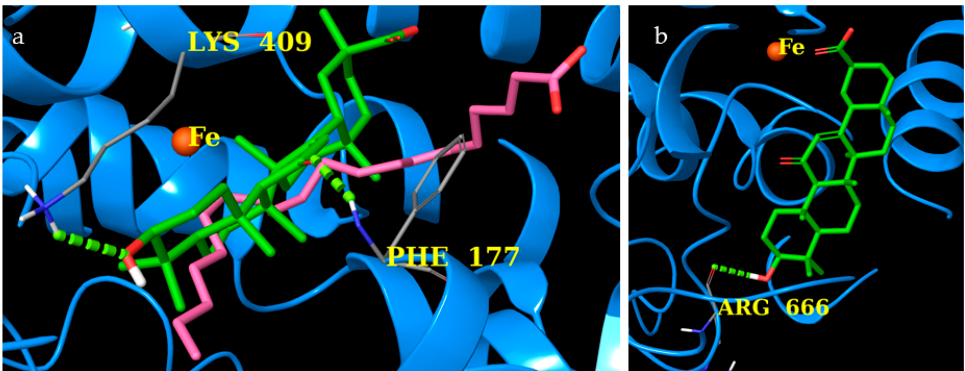
Figure 12. ( a ) Rigid docking and induced fit ( b ) of AG (colored by atom types: C green, O red, polar H white) in the binding site of 5-lipoxygenase (5-LO) (blue ribbons and Fe2+ as an orange sphere). Green dotted lines represent H-bonds, and original arachidonic acid (AA) molecule is in pink.